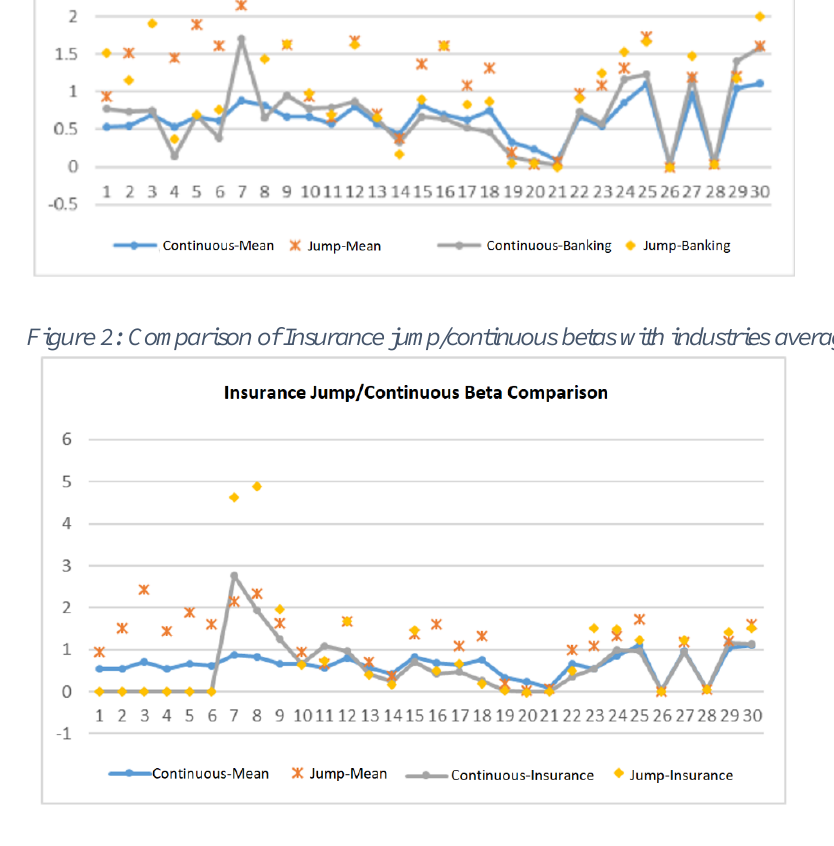
Figure 3: Comparison of Investment jump/continuous betas with industries